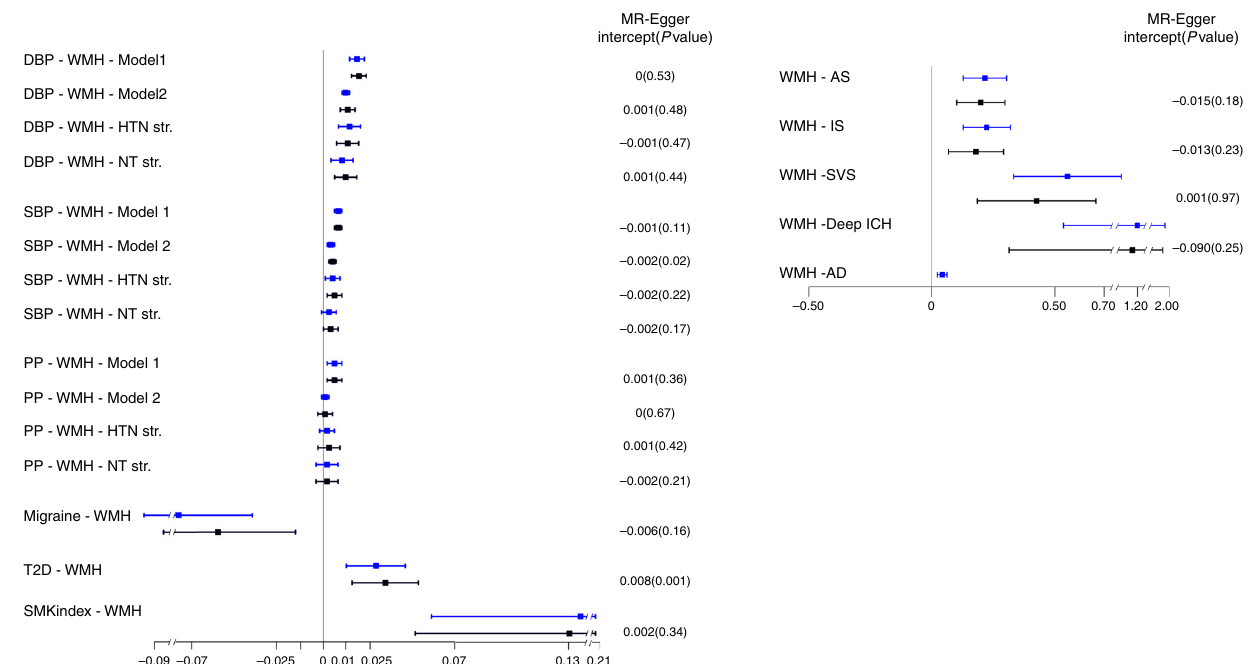
Fig. 4 Mendelian randomization results of vascular risk factors with WMH burden (box A) and WMH burden with neurological traits (box B). Point estimates and con fi dence intervals (blue) from the inverse-variance weighted (IVW) method are shown along with the point estimates and 95% con fi dence interval (black) from sensitivity analyses after fi ltering out potentially pleiotropic outlier variants. The intercept and p-value from the MR-Egger method is displayed on the far right (an intercept term signi fi cantly differing from zero at the conservative threshold of P < 0.05 suggests the presence of directional pleiotropy). SBP systolic blood pressure, DBP diastolic blood pressure, PP pulse pressure, HTN hypertensive, NT normotensive, Str. stratum, AS all stroke, IS ischemic stroke, SVS small vessel stroke, ICH intracerebral hemorrhage, AD Alzheimer ’ s disease, T2D type II diabetes, SMKindex lifetime smoking index, WMH white matter hyperintensity, Model 1 Main effects adjusted for age, sex, principal components for population strati fi cation, intracranial volume; Model 2 Model 1 + hypertension